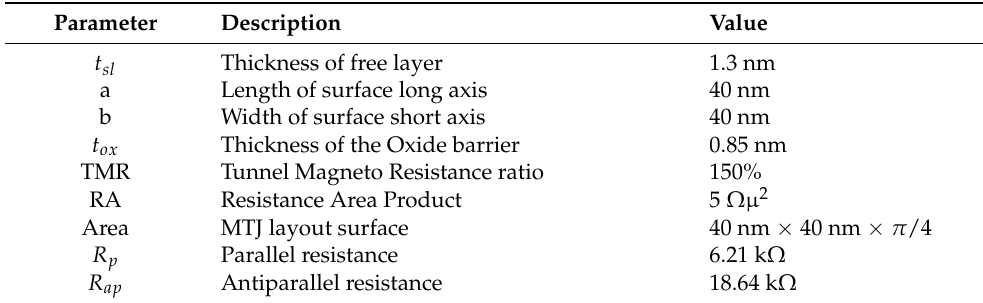
Table 1. Magnetic Tunnel Junction parameters used in